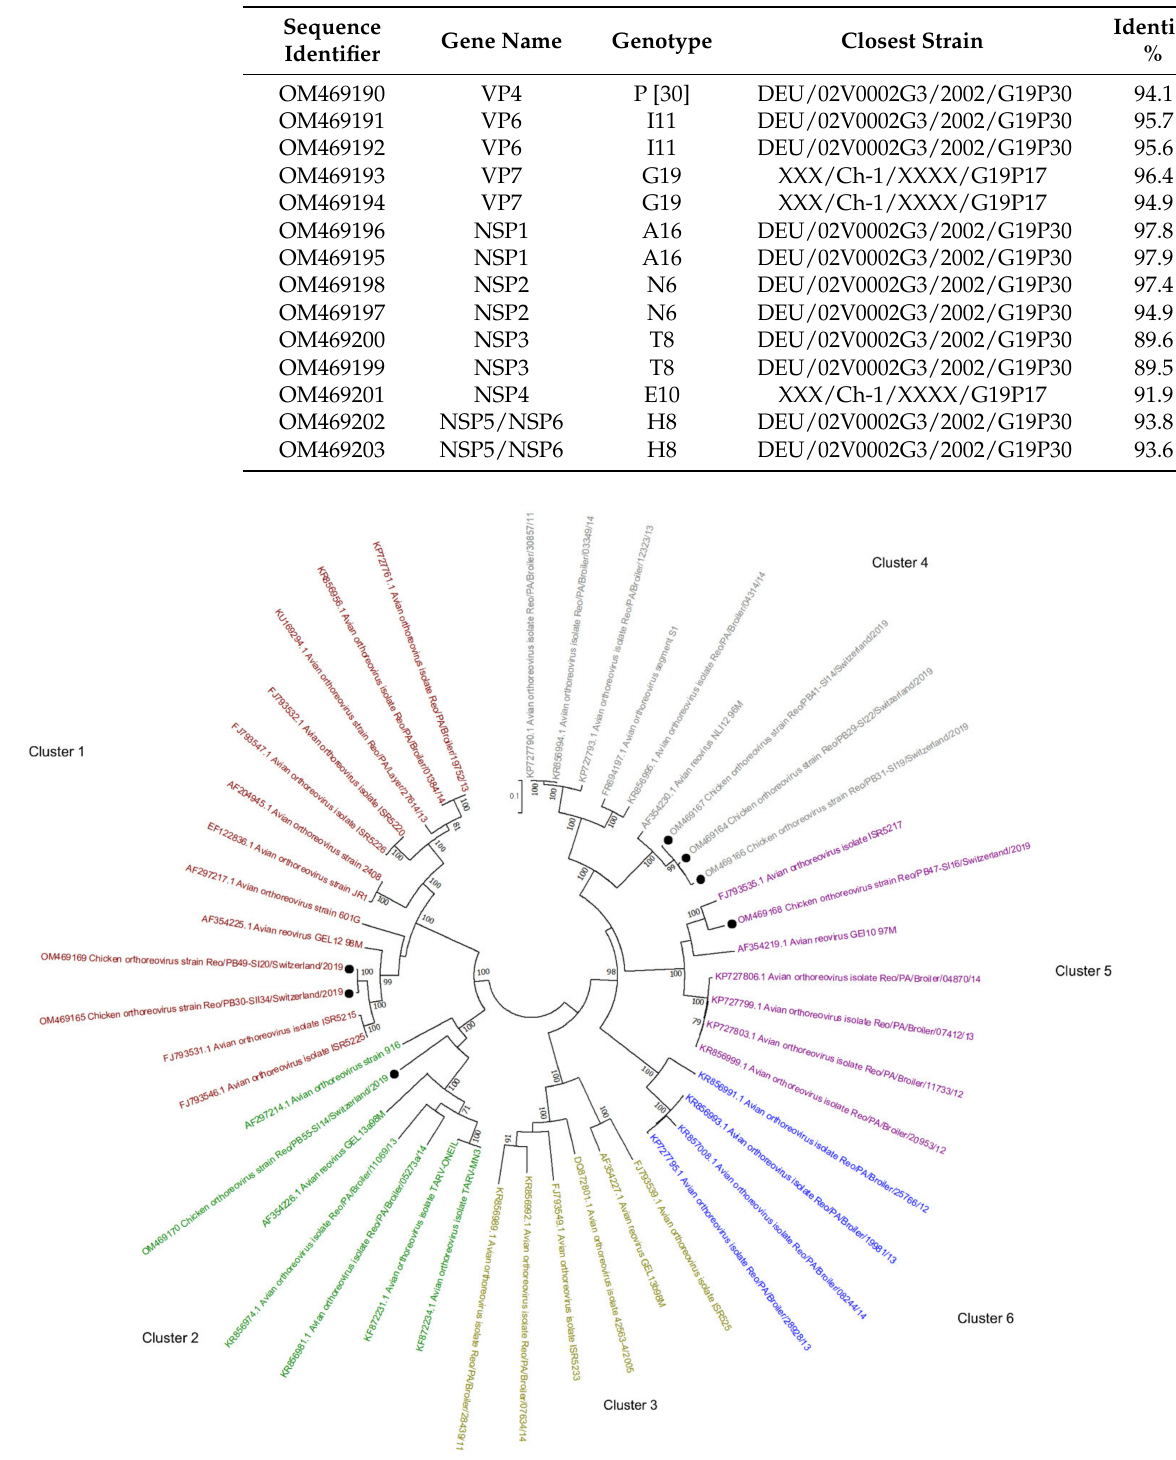
Figure 5. Phylogenetic tree based on the σ C aa identity of selected avian orthoreoviruses. The tree shows 6 genotyping clusters in red, green, olive, blue, purple, and gray for Clusters 1, 2, 3, 6, 5, and 4, respectively. Sequences obtained in this study are marked with black dots. Phylogenetic analysis was performed using the maximum likelihood algorithm based on the Tamura–Nei model with the 1000 replication bootstrap method. Only values ≥ 70% were displayed. Evolutionary analyses were conducted using MEGA